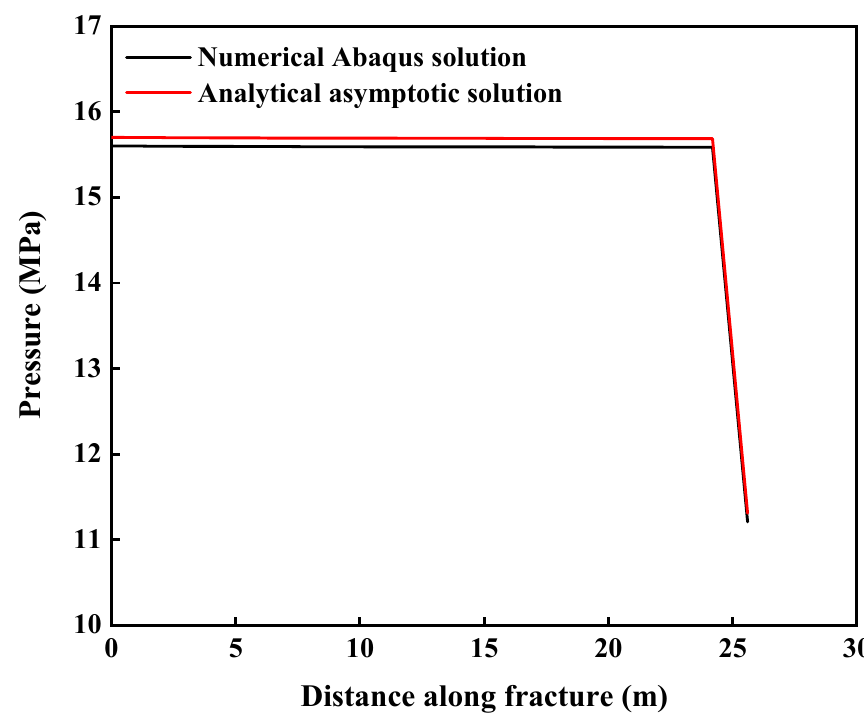
Figure 22. Pressure distribution along fracture at the final time near injection point (K vertex).